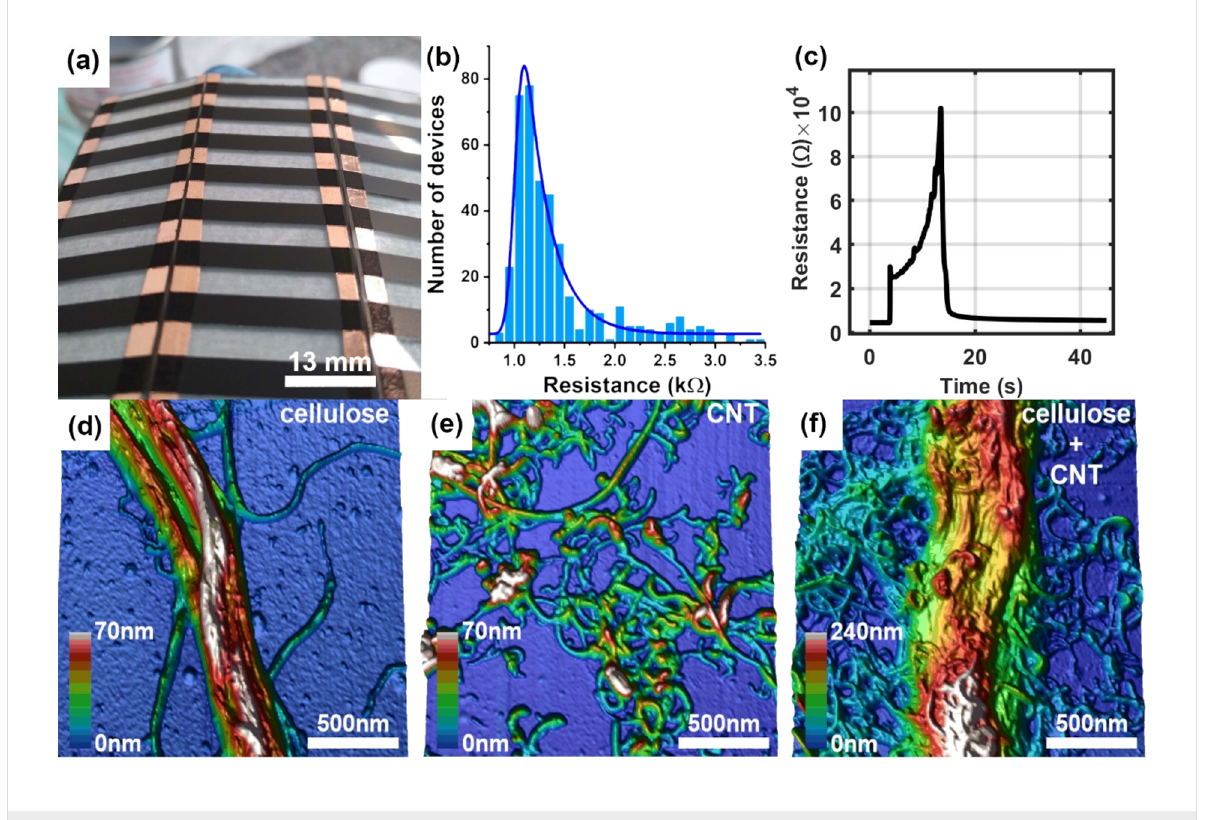
Figure 1: (a) Array of transducers; (b) histogram of sensor resistance distribution; (c) transducer resistance change as a function of time during liquid sensing; AFM images of (d) microfibrillated cellulose (MFC), (e) MWCNTs, and (f) MFC entangled with MWCNTs.